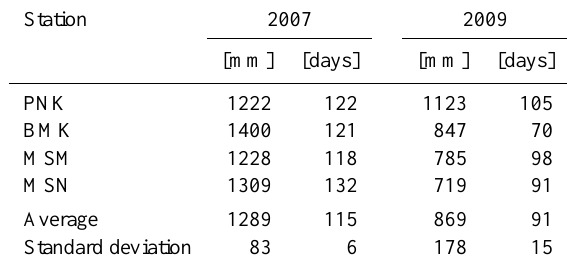
Table 2. Annual rainfall and the number of rainy days recorded at four weather stations (for location of stations see Fig.